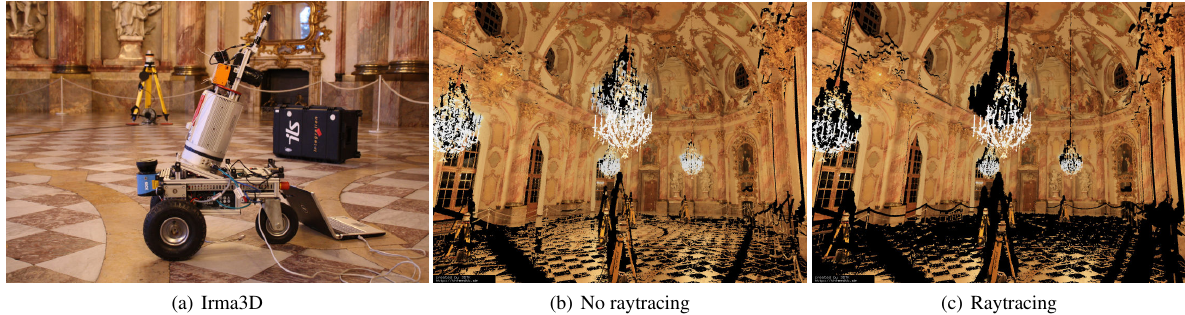
Figure 7: (a) Irma3D in the Imperial Hall of the W¨urzburg Residence during calibration. In the background is one of the transmitters for the iSpace localization system and a box with two reflective markers for the calibration procedure. (b) + (c) One scan from the Imperial Hall colored with the information from the photos without (a) and with (b) correction from using raytracing. It is obvious that the raytracing methods removes wrongly colored points.